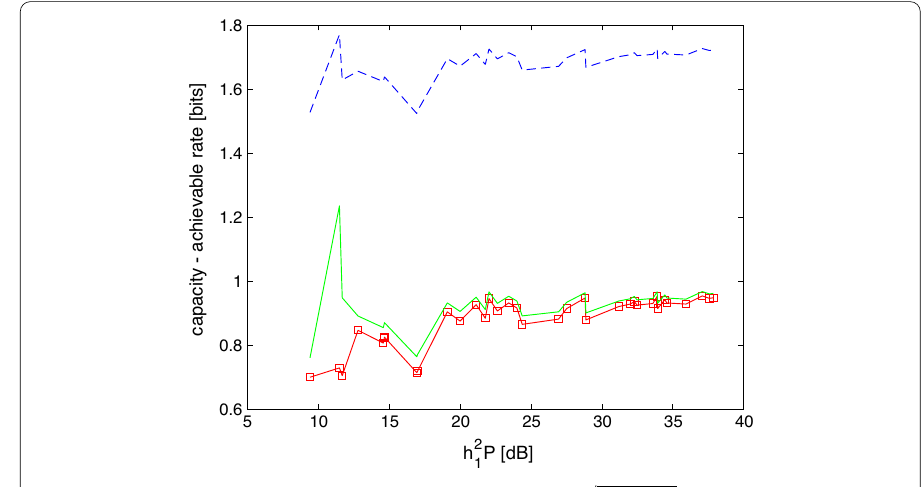
h 2 1 h 4 1 P . The top curve ‘blue dashed N + 2 = (cid:31)